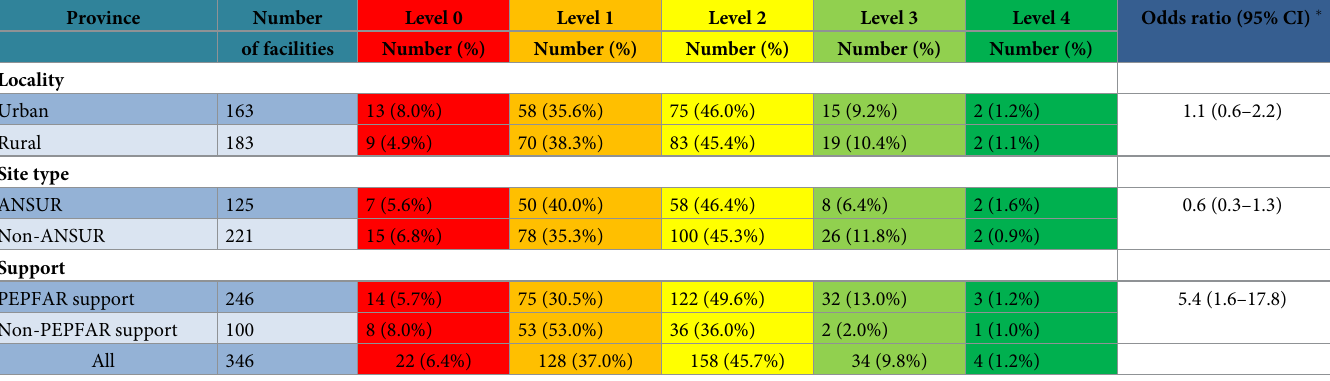
Table 5. Stratified analysis of implementation levels by locality, site type and PEPFAR support: Quality of HIV rapid testing practices, South Africa.